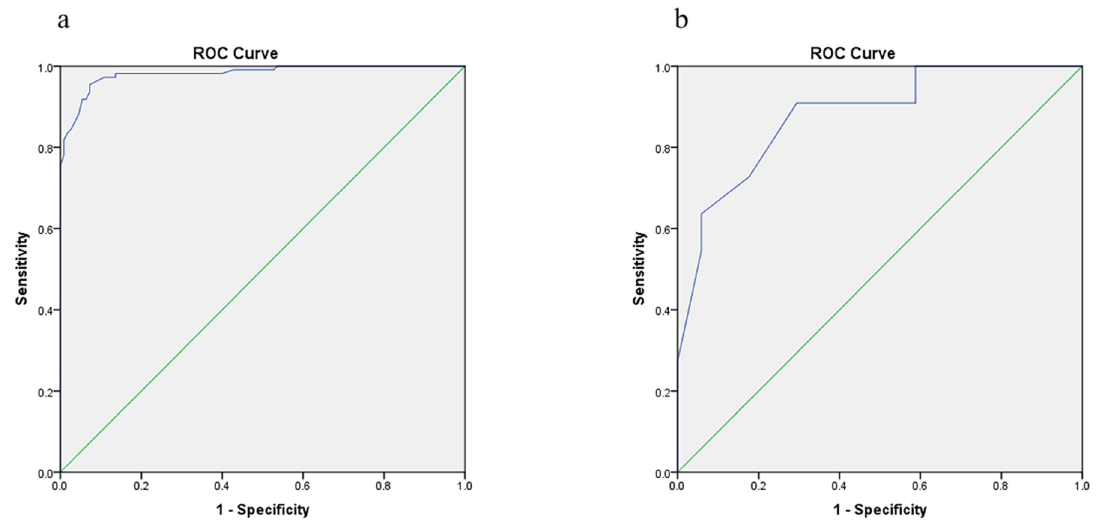
Figure 4. AUROC curve used to estimate the discriminative power the prediction model. ( a ) Model construction group; ( b ) validation group. AUROC, Area Under Receiver Operating Characteristic.